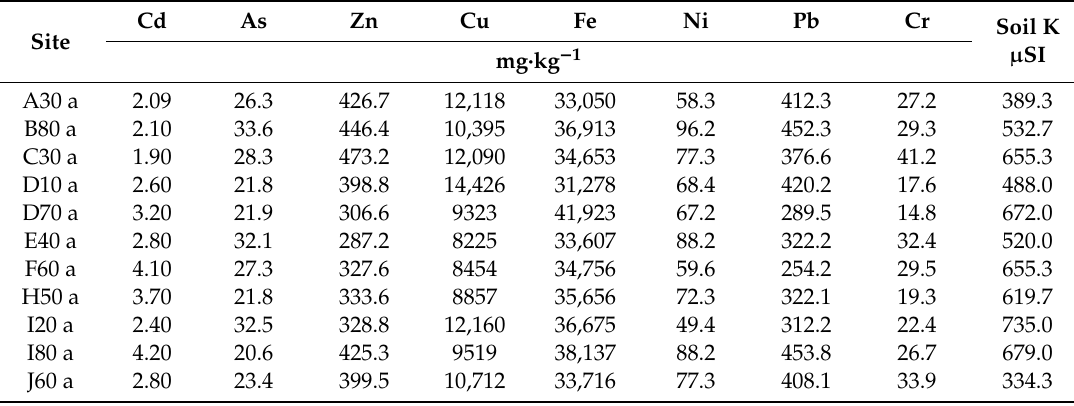
Table 3. Results of chemical analyses for the first stratum at a 0–10 cm